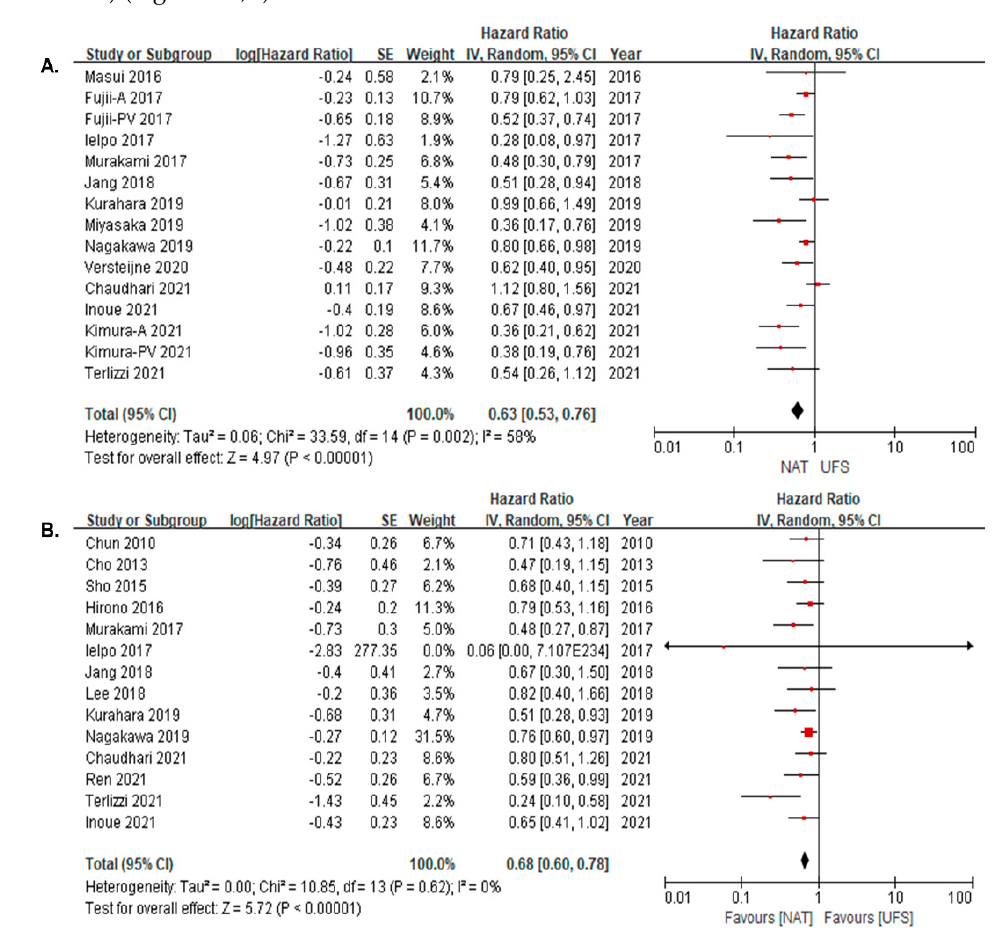
Figure 2. Overall survival of NAT versus UFS ( A ) in intention-to-treat analysis [6,10,12,20,21,23–29,31]; ( B ) in resected group [6,9,12,17–19,21–23,25,27,28,30,31]. Red squares correspond to individual studies. Squares size is proportional to the weight of the study while black diamonds shapes correspond to pooled studies.